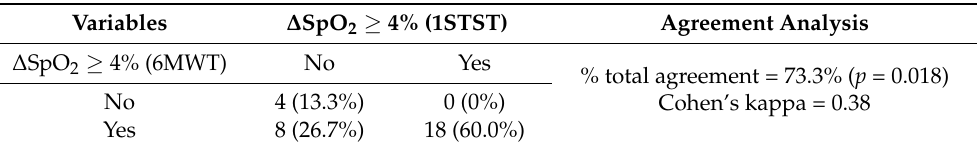
Table 4. Agreement between ∆ SpO 2 ≥ 4% in the 1STST and the 6MWT, evaluated by Cohen´s kappa (k). (1STST = 1-min sit-to-stand test; 6MWT = 6-min walking test; SpO 2 = oxygen saturation).